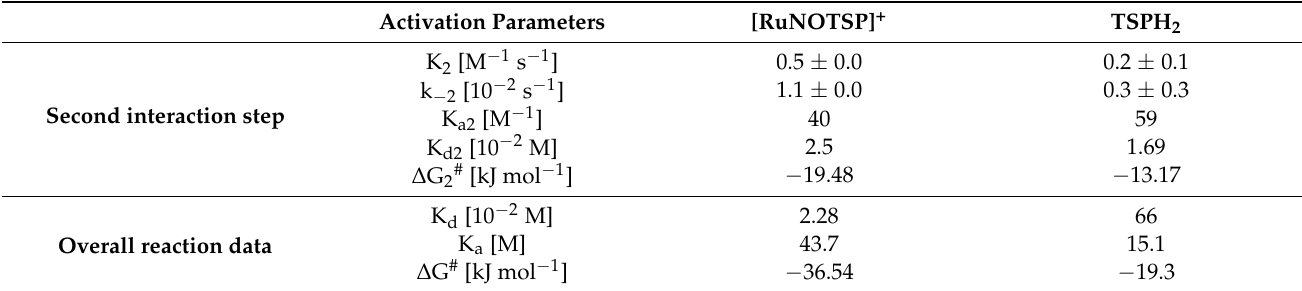
Table 4. Cont. Activation Parameters